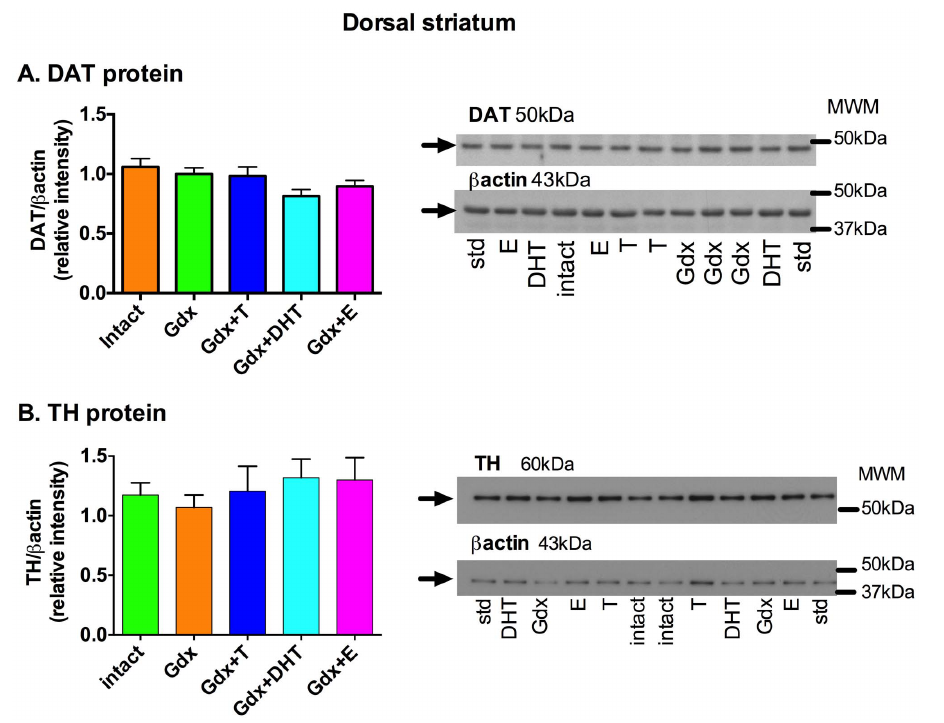
Figure 4. Effect of gonadectomy and sex steroid replacement on dopamine transporter protein and tyrosine hydroxylase protein in adolescent male rat dorsal striatum. (A) DAT protein was unchanged in the dorsal striatum by gonadectomy and sex steroid replacement (F=2.39, df = (4,45), p =0.07). Representative immunoblots of a subset of dorsal striatum samples from all five groups show DAT (50 kDa) and b -actin (43 kDa). (B) TH protein was unchanged by gonadectomy or sex steroid replacement in the dorsal striatum (F=0.41, df = (4,45), p =0.78). Representative immunoblots of a subset of dorsal striatum samples from all five groups show TH protein (60 kDa) and b -actin protein (43 kDa). * p , 0.05, n=9–10/group. (MWM, molecular weight marker; std, internal standard).